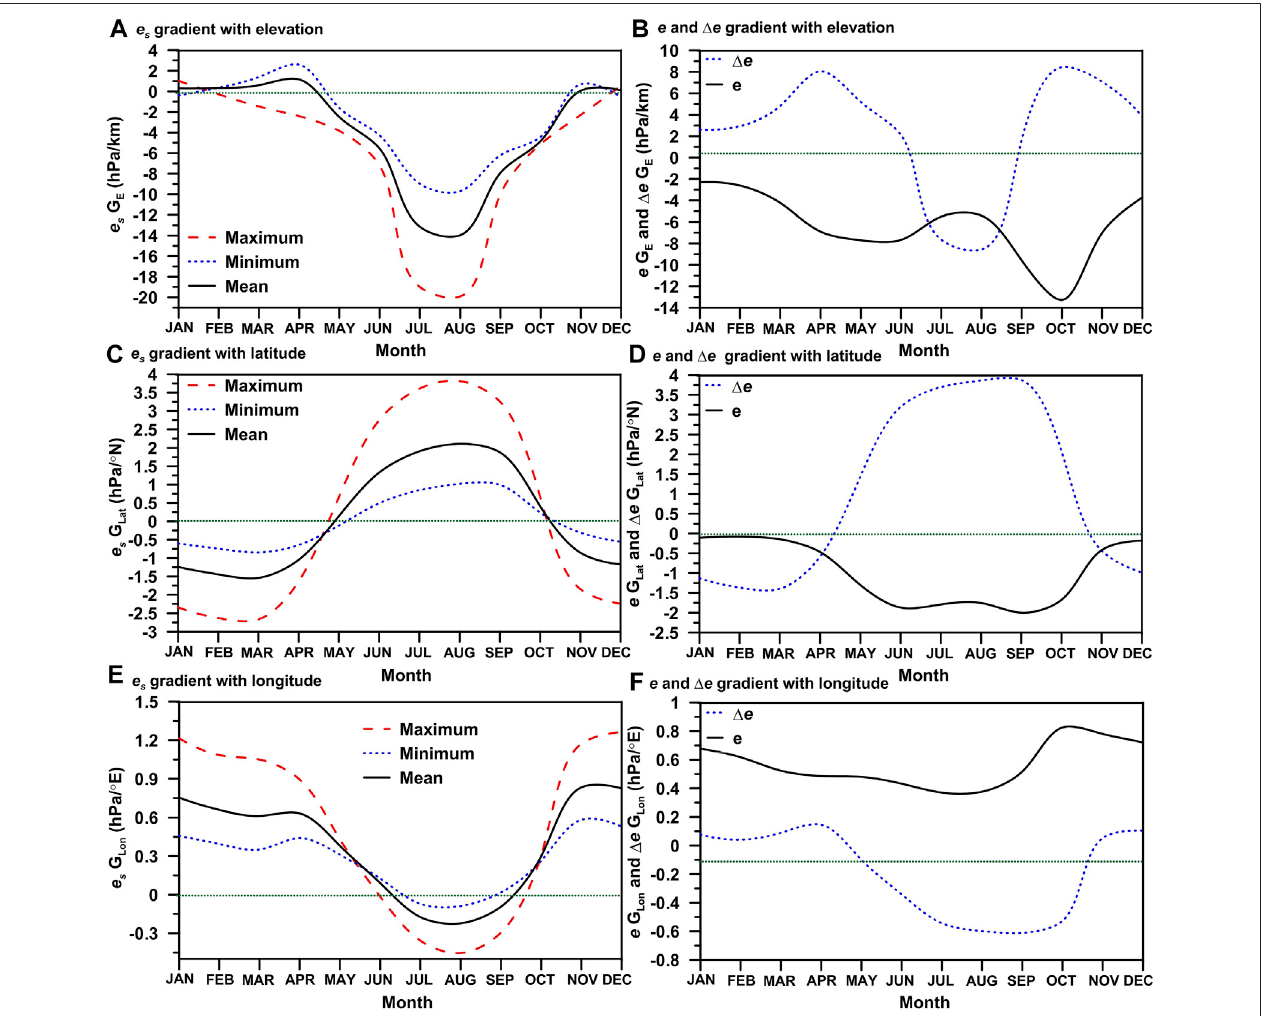
FIGURE 9 | The annual cycle of e s , e and Δ e gradients with elevation (A,B) , latitude (C,D) and longitude (E,F) over the study region.